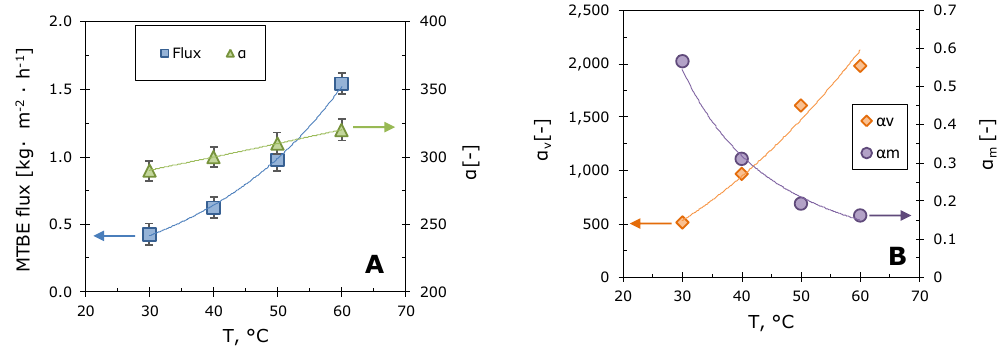
Figure 6. Temperature dependences of MTBE flux and MTBE/water separation factor ( A ); temperature dependences of the phase transition separation factor α v and membrane selectivity α m ( B ). The linear velocity of the feed mixture was 4.0 cm·s −1 , 1 wt.%. MTBE in water, composite membrane M10/MFFK.